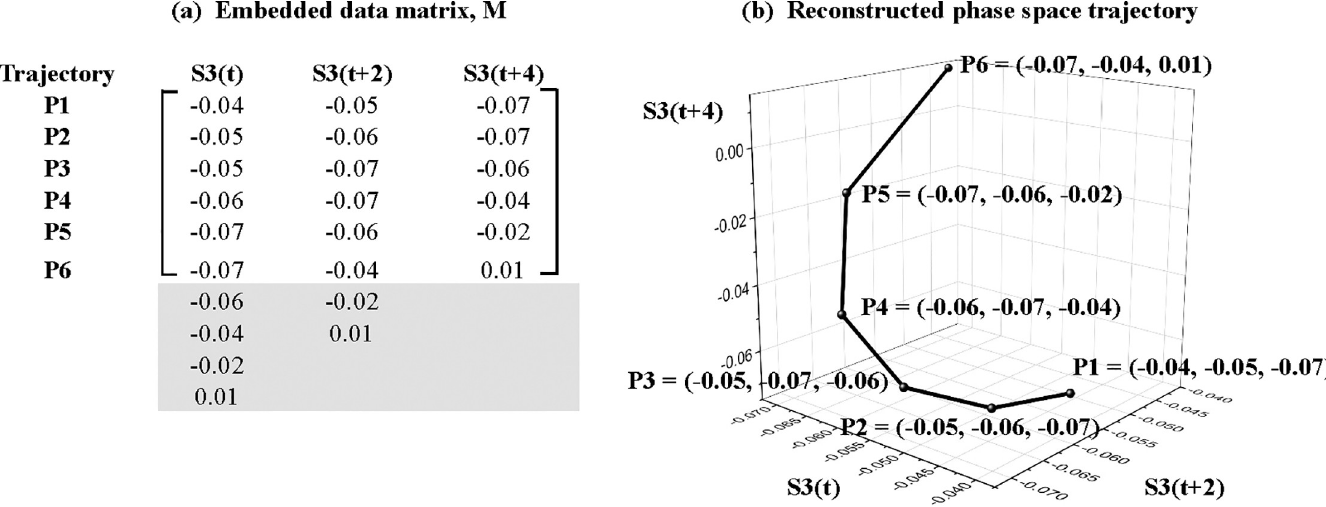
Fig 5. The embedded data matrix and reconstructed phase space. (a) The time-delay method of phase space reconstructed is implemented by constructing an ‘embedded data matrix’, M , with the observed time series in the first column followed by columns storing its forward-delayed copies. For example, we embed the first ten observations of the S3 record, where observations in the gray rectangle are lost to the forward-lagging process; (b) The scatter plotted rows of M are multidimensional points on a reconstructed attractor.